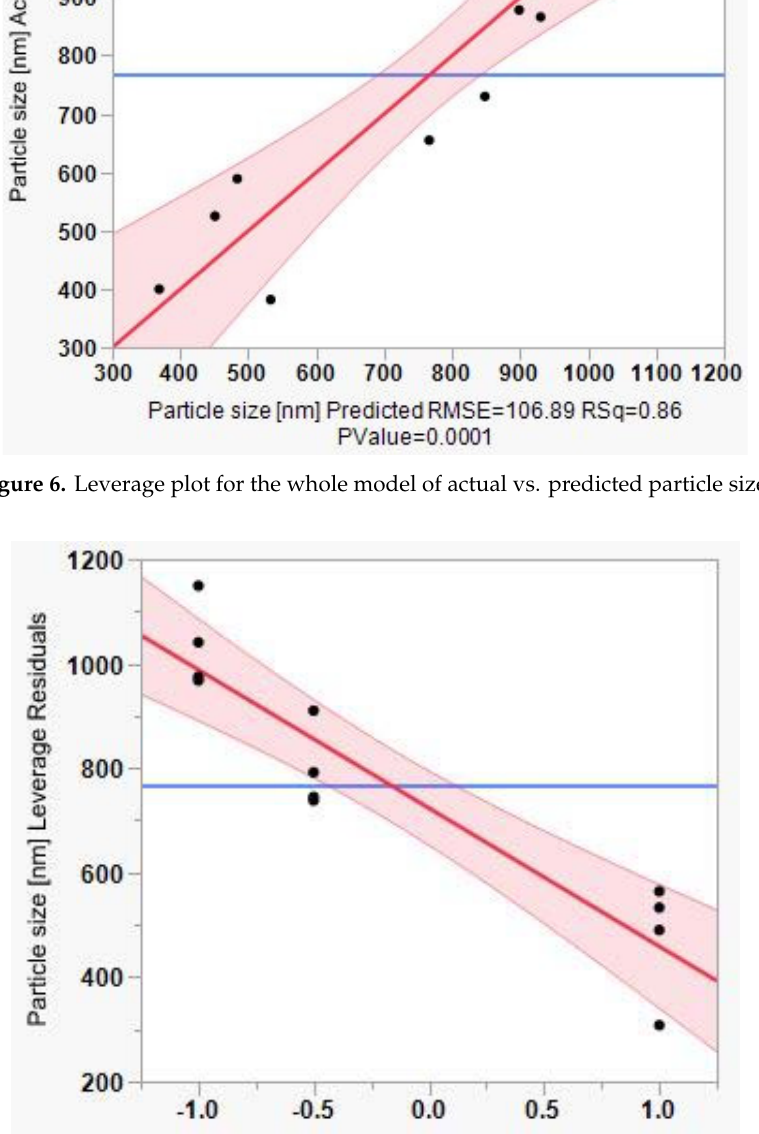
Figure 7. Leverage plot for phospholipon 90H (PL90H).